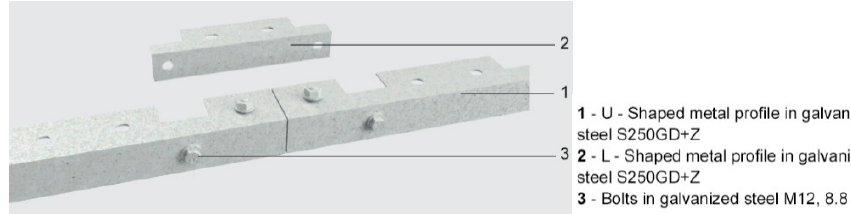
Figure 3. Connection between two adjacent U–shaped profiles.